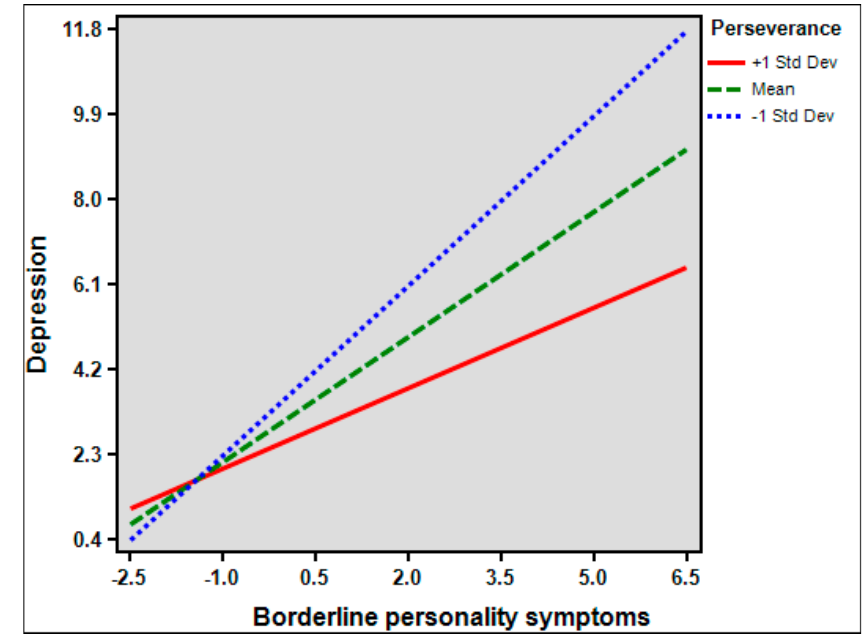
Figure 2. Depression scores as a function of the interaction between borderline personality disorder symptoms and perseverance.